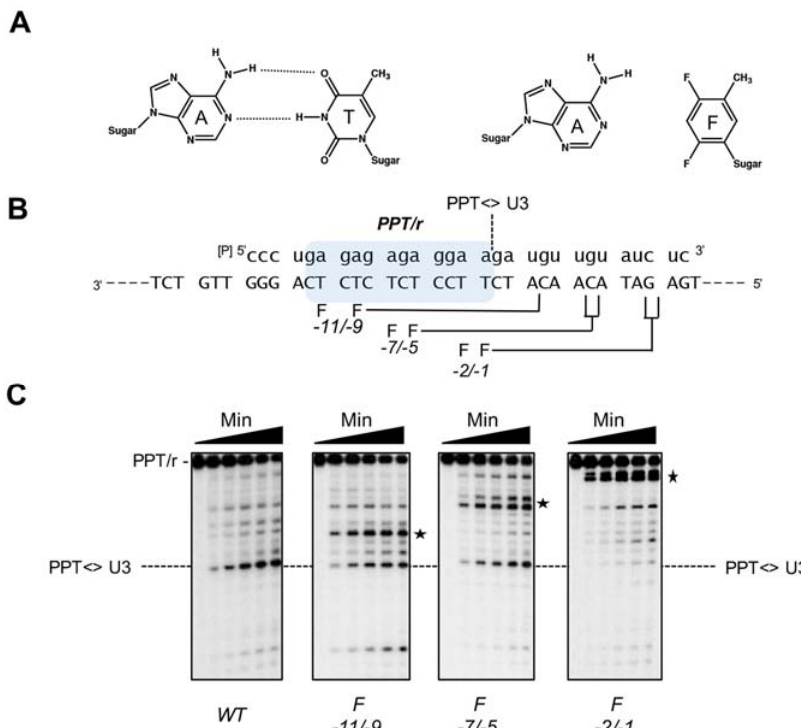
Figure 8. Modulation of Ty3 PPT cleavage by targeted insertion of non-polar pyrimidine isosteres. ( A ) Representation of an A:T base pair and its A:F counterpart; ( B ) Model Ty3 RNA/DNA hybrid and a summary of pyrimidine isostere mutagenesis. DNA and RNA strands are depicted in capital and small letters, respectively, and the scissile PPT/U3 junction is indicated. Base-pair numbering is relative to the PPT/U3 junction (i.e., the last base of the PPT is denoted − 1). Sites of cleavage relative to the position of T-F modification in the DNA strand are indicated; ( C ) experimental data. WT, unmodified hybrid, indicating cleavage at the PPT/U3 junction. For additional panels, the position of T-F modification in the DNA strand are indicated, and the asterisk illustrates the relocated RNase H cleavage in response to these modifications. Adapted from [50,51].